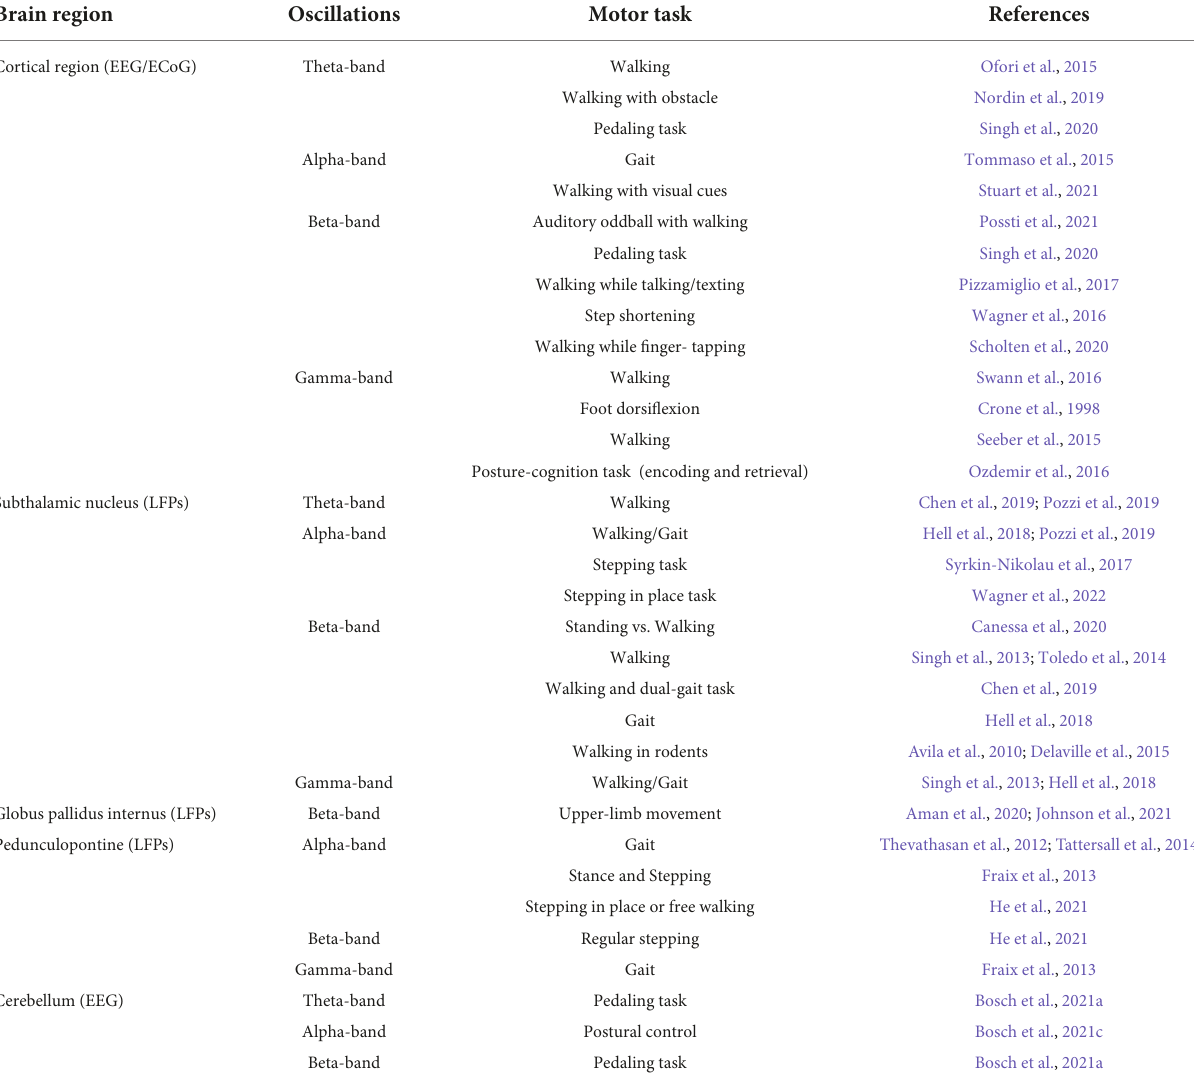
TABLE 1 Summary of the studied oscillations during gait/walking and dual-tasks in the cortical and subcortical structures in patients with